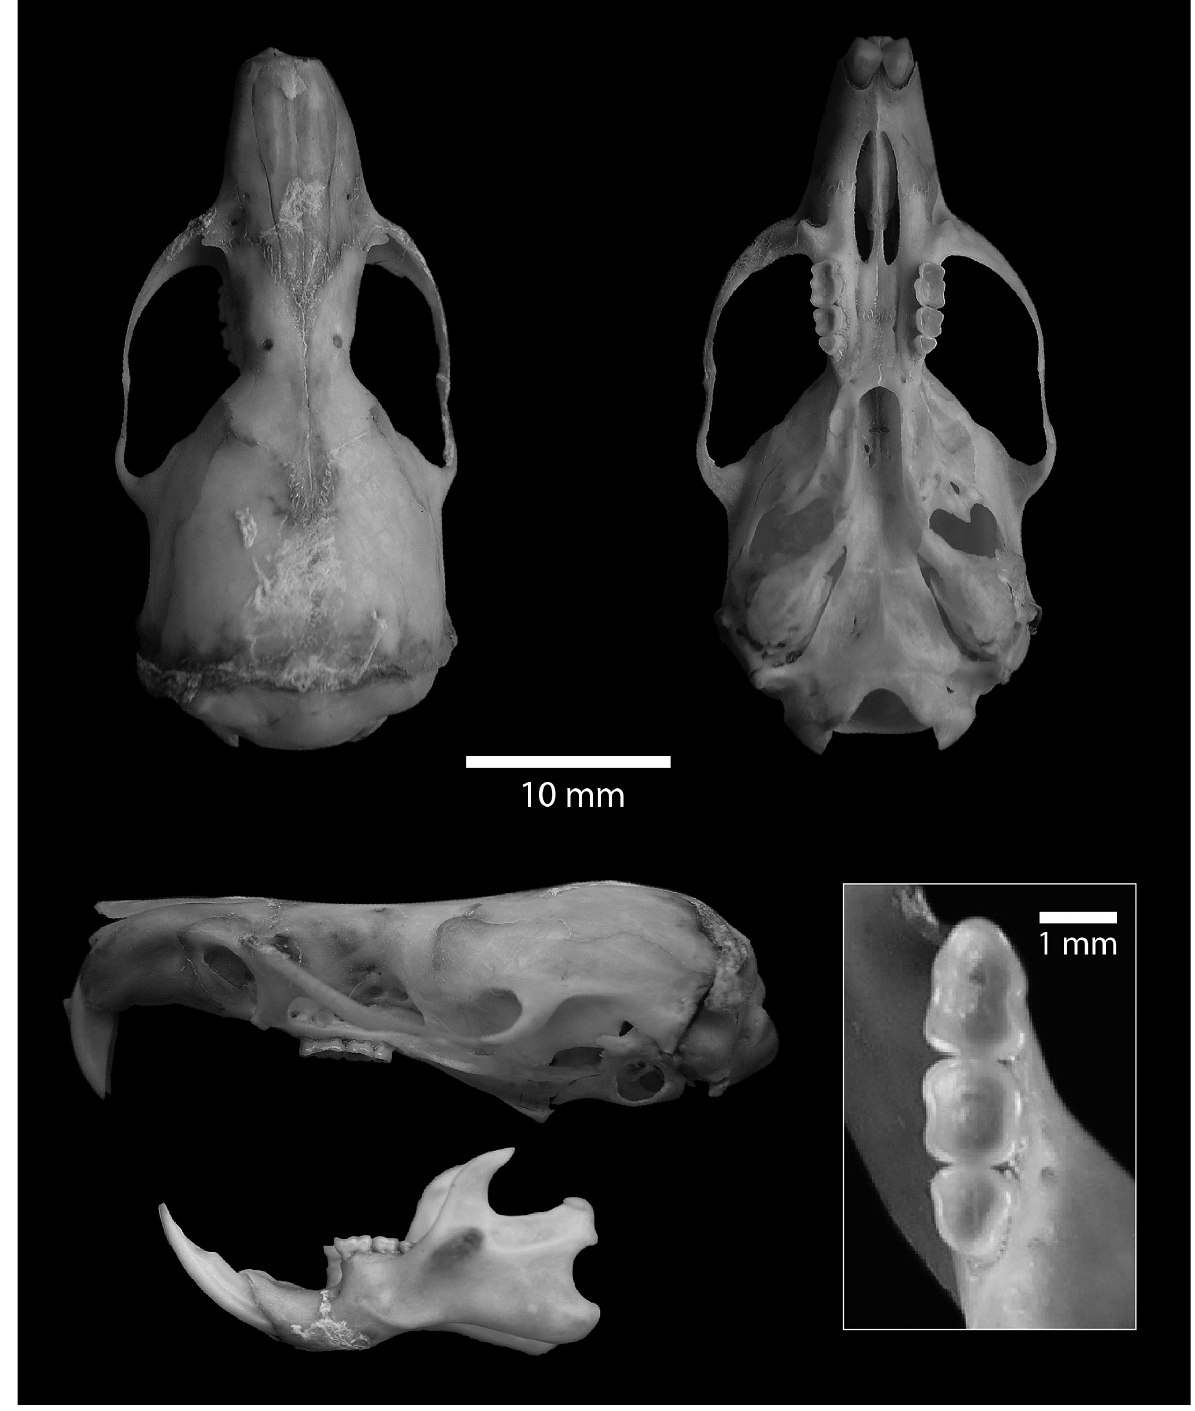
Figure 4. Dorsal, ventral, and lateral view of the skull and mandible of Tweedy’s Crab-eating Rat, Ichthyomys tweedii (MNCR-M2106), collected in Quebrada Wilson, Las Cruces Biological Station, San Vito, Puntarenas Province, Costa Rica. Inset shows detail of the right mandibular molar tooth